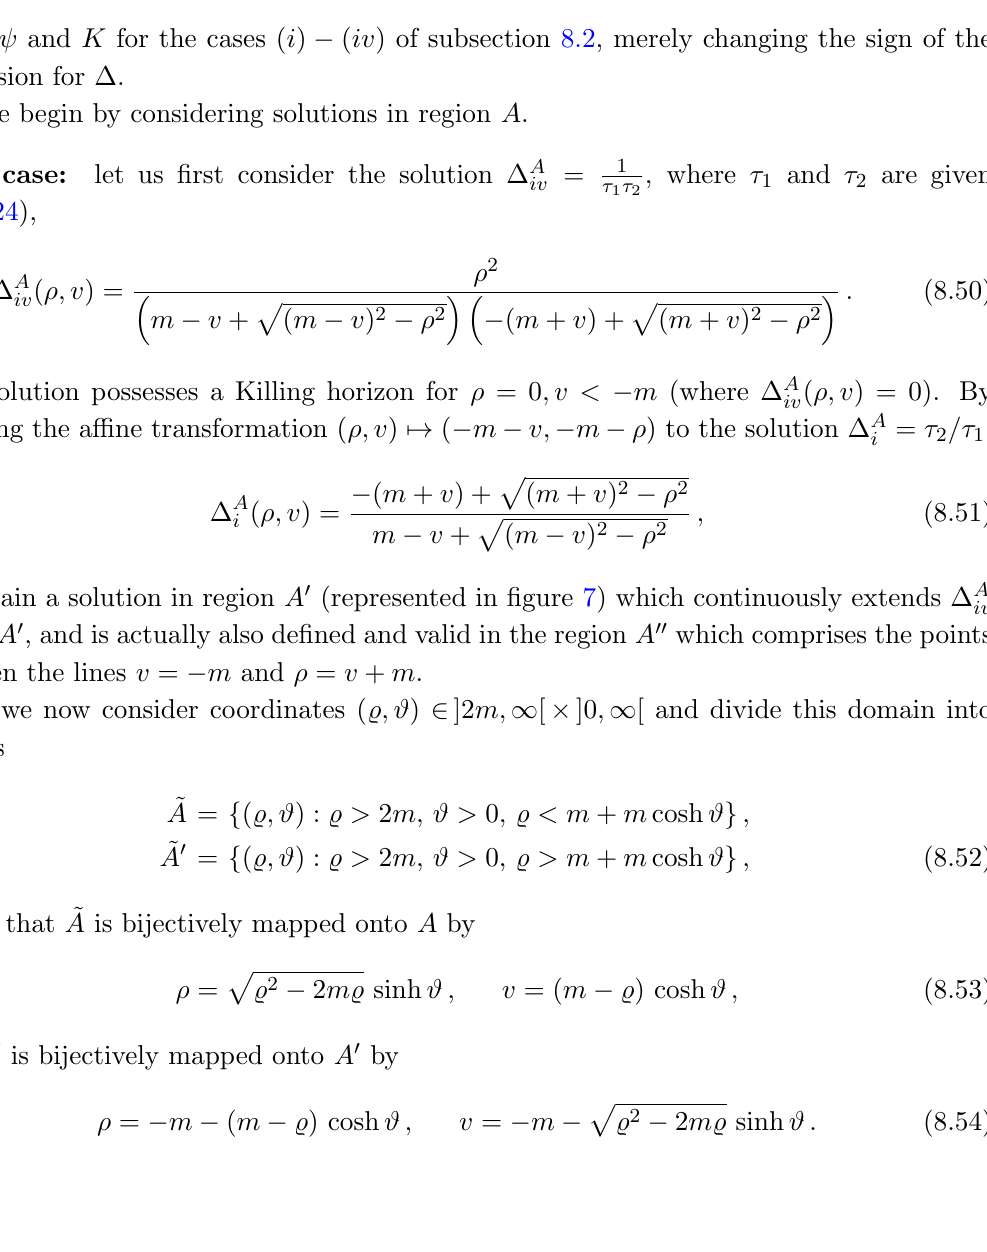
Figure 7. Weyl upper-half plane with solutions extended past regions A and B